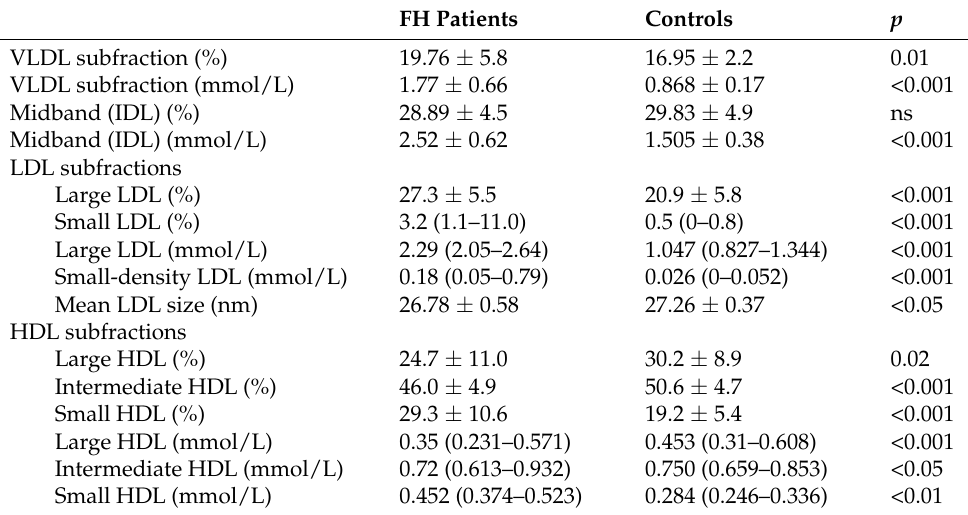
Table 2. Concentrations and proportions of lipoprotein subfractions in study participants. Values are expressed as mean ± SD or median (lower quartile, upper quartile). FH Patients Controls